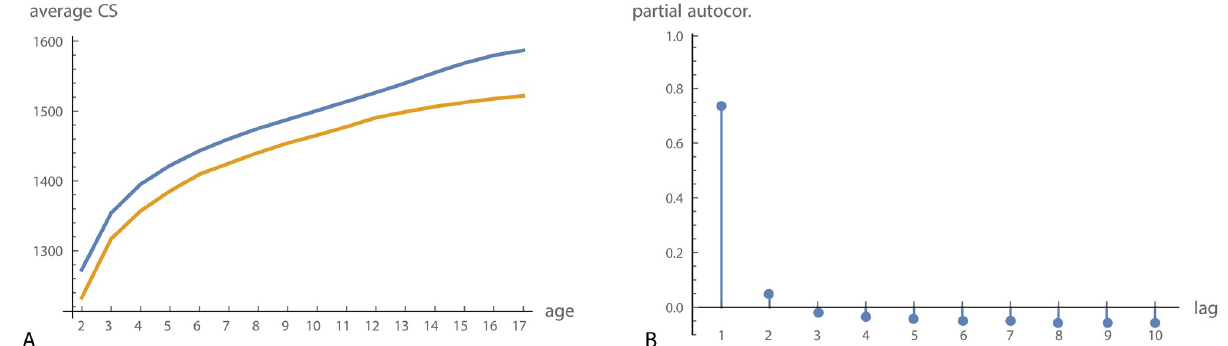
Fig 3. Craniofacial size. (A) Average craniofacial size (centroid size) for boys (blue) and girls (orange) in the Denver growth sample. (B) Partial autocorrelation function for craniofacial size.